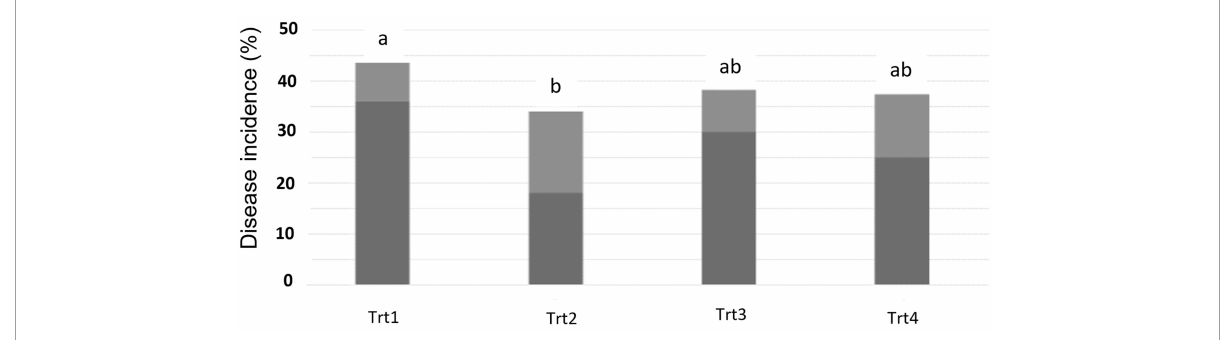
FIGURE1 Fusarium head blight disease incidence, as assessed at 28 days post inoculation of T6085. Data are the mean (dark gray) + SD (soft gray) percentage of spikes showing visual symptoms of FHB ( n = 5 replicates, with 30 spikes assessed per sample). Trt1 was the non-inoculated control. In Trt2, T. gamsii strain T6085 spore suspension was applied onto wheat spikes at anthesis. In Trt3, T6085 was applied to crop residue on the soil surface. In Trt4, T6085 was applied onto both spikes and crop residue at anthesis. Treatment means indicated by different letters are significantly different (ANOVA with Tukey HSD, p <